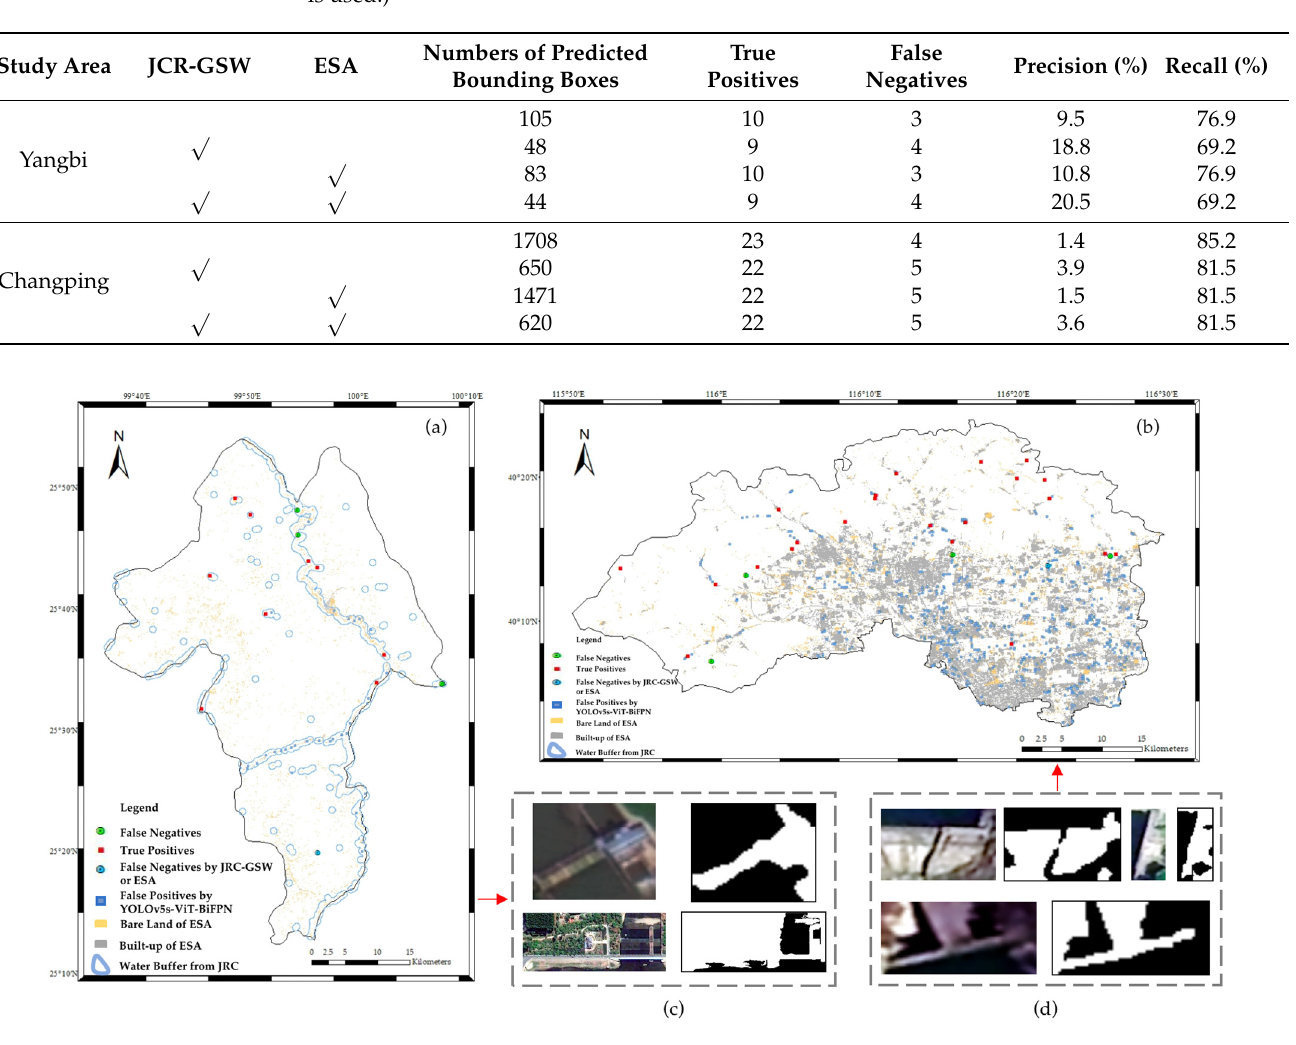
Table 5. Evaluation results of dam detection in two study areas. (A check mark means the method is used.)